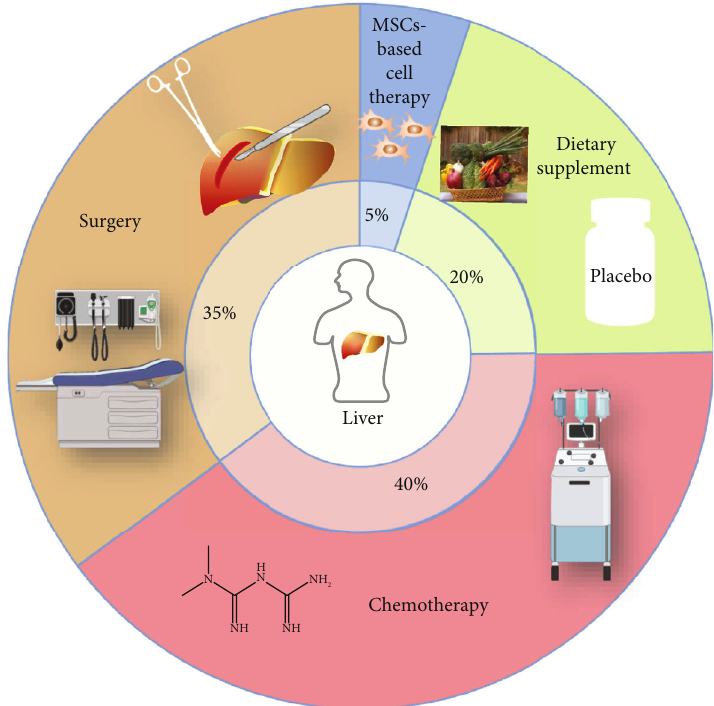
Figure 2: Treatments for end-stage liver diseases. The proportion of MSC-based cell therapy clinical trials compared with other conventional trials in liver fi